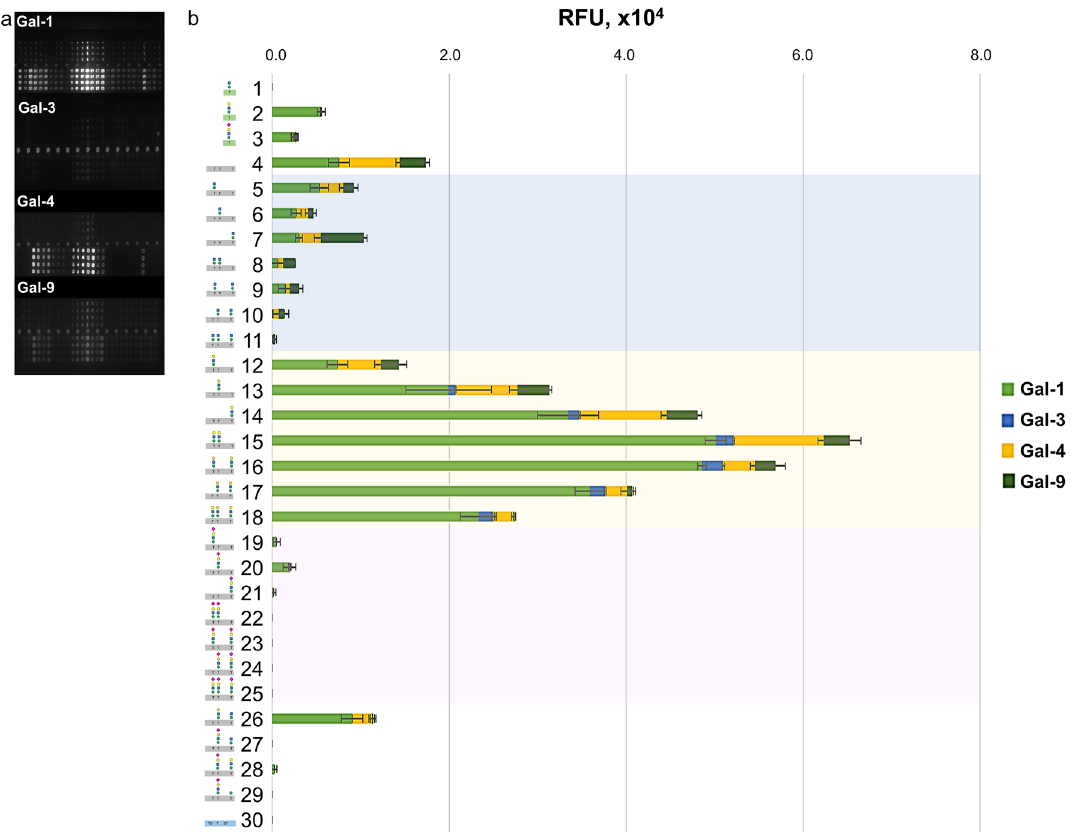
Figure 3. Fluorescence image of microarray chip is taken after treatment of 20 and 200 μM core M1 α-DG glycoconjugates with 10.0 μg/mL galectin solution ( a ). Stacked chart of signal intensities of 200 μM core M1 α-DG glycoconjugates with 3.20 μg/mL of wild-type galectins ( b ). The relative interaction of 20 and 200 μM core m1 α-DG glycoconjugates with 0.10 μg/mL to 32.0 μg/mL Gal-1, -3, -4, and -9 are in Supplementary Fig. S4 and S5,